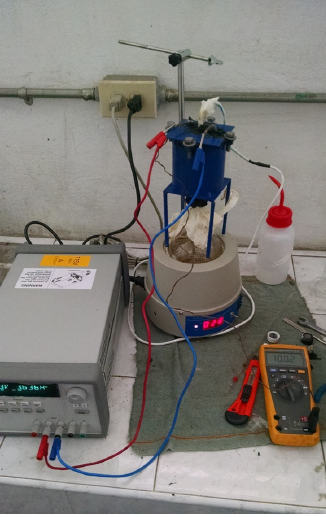
Figure 1. Bench-scale fixed bed adsorber